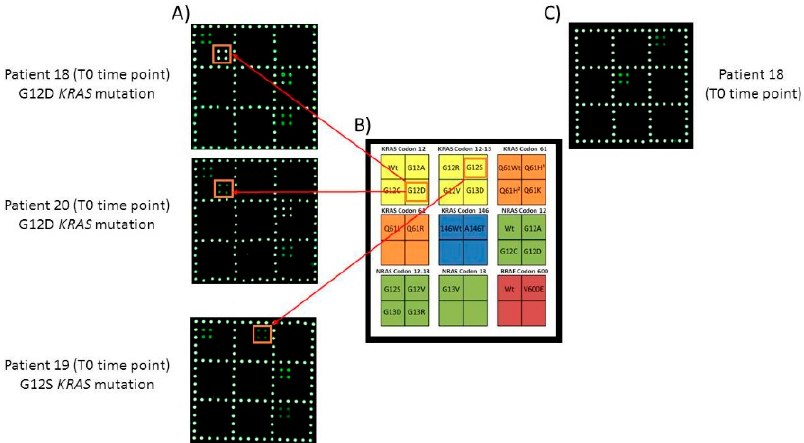
(mCRC) patients (n.7 and n.13) and respective fractional abundance of the mutated KRAS allele at the 3 time point: Patient n.7 = G12C KRAS mutation (upper panel) and Patient n.13 = A146T KRAS mutation (lower panel). Mutants are clustered in the upper left corner with high Fluorescein (FAM) fluorescent intensities (blue), wild-type is clustered in lower right corner with high Hexachloro-fluorescein (HEX) fluorescent intensities (green) while mutant plus wild-type sequences are clustered in the upper right corner (orange). The empty droplets are represented in black.